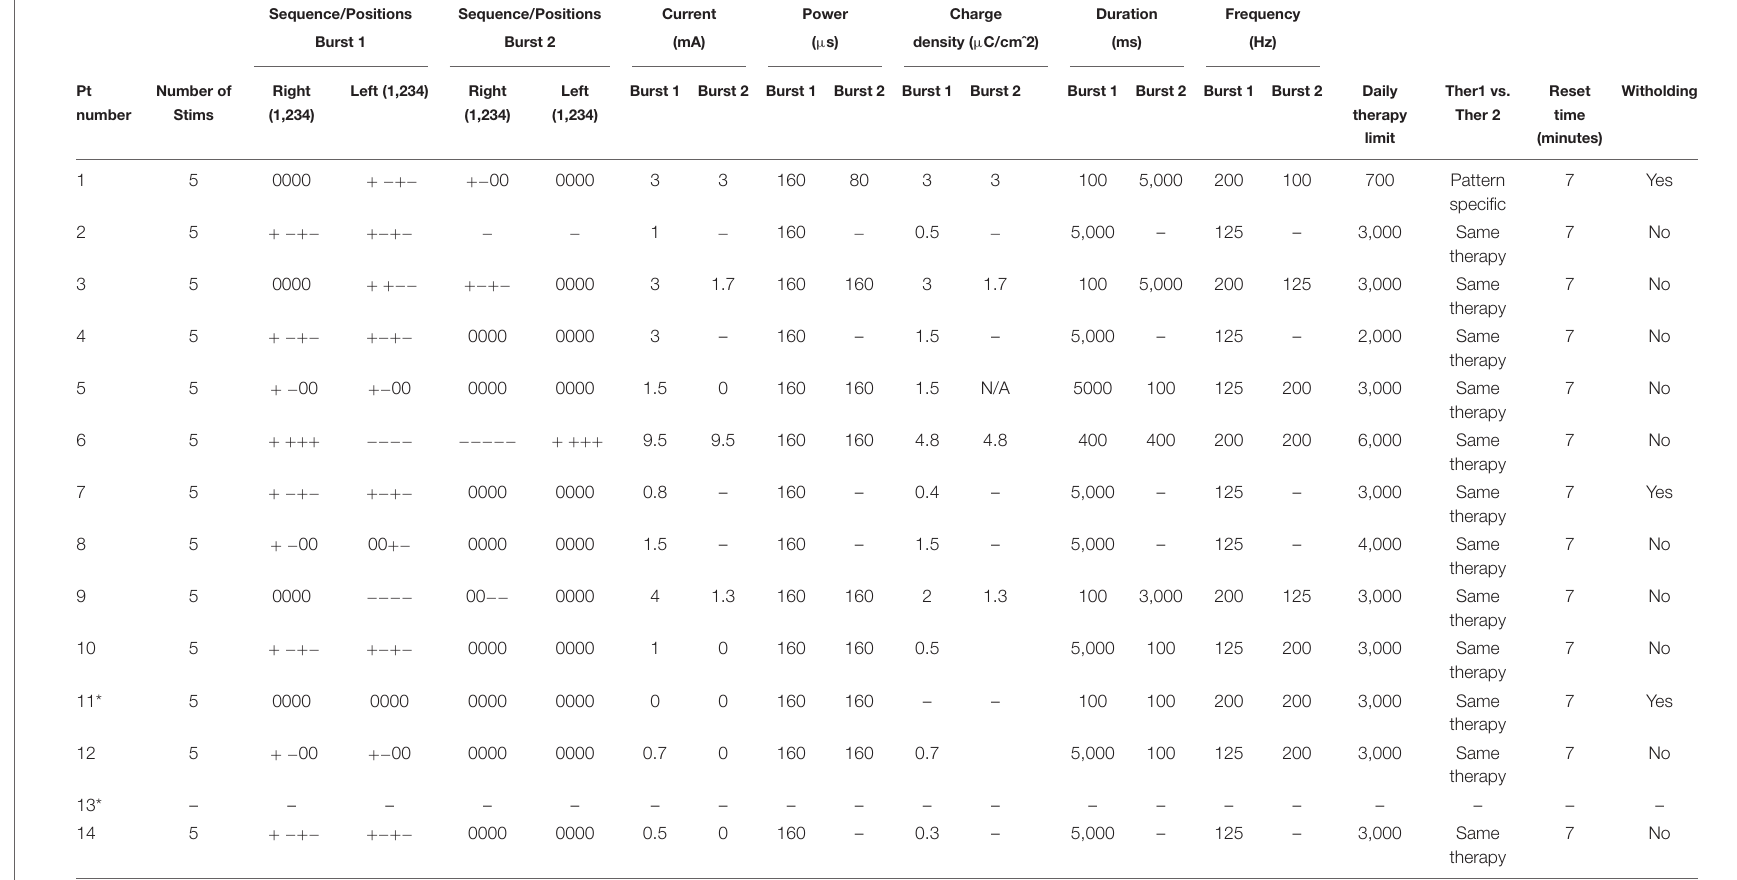
TABLE 3 | Stimulation